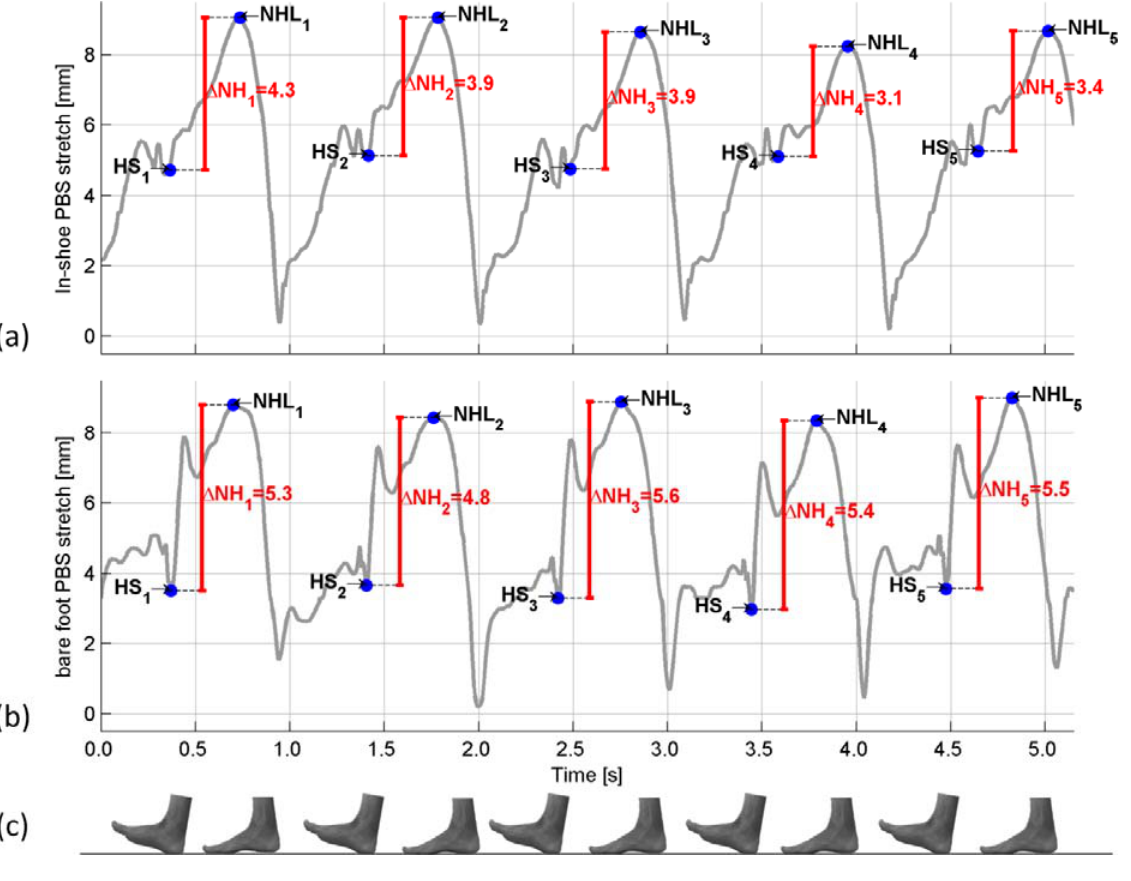
Figure 8. Measurements of the navicular height. The measurements were aligned by hand. ( a ) In-shoe measurement of the navicular drop using the PBS system. The sensor was found to be resistant to a person wearing a shoe. The time of the events of NHL and HS is located by hand, and for this reason the location is an estimate; ( b ) Bare foot measurement of the navicular drop using a PBS; ( c ) Foot indicating the stage of